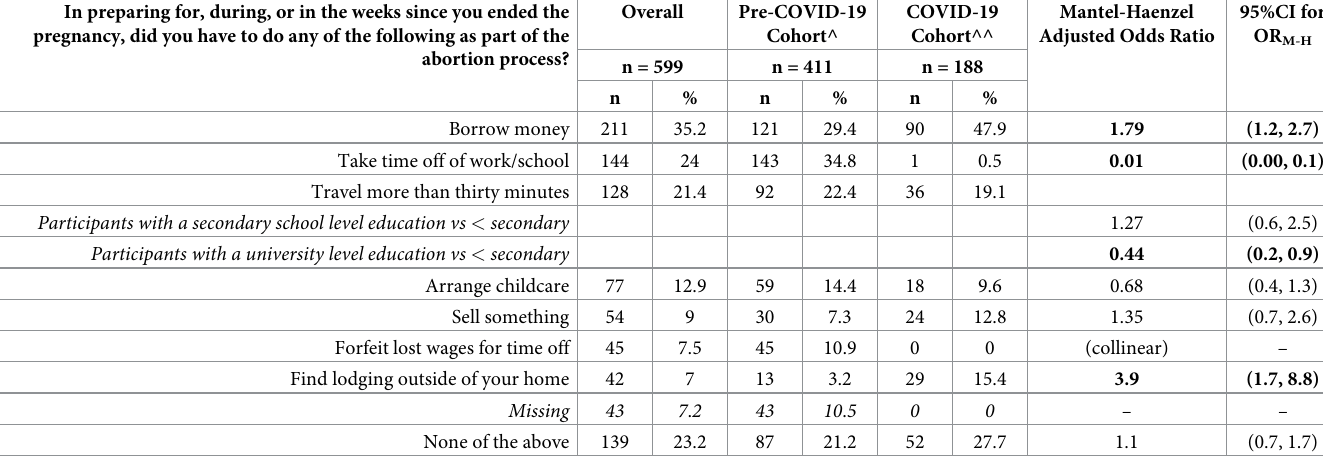
Table 2. Burdens experienced as part of a self-managed abortion process among 599 callers to a safe abortion hotline in Nigeria between October 2019 and June 2020. The first three columns present unadjusted proportions overall and by time period, and the two right-most columns display Mantel-Haenzel odds ratios (OR) for each burden adjusted for participant age and education at baseline, with corresponding 95% Confidence Intervals for the OR. Due to an interaction detected with educa- tion, the ORs for COVID-19 pandemic and having to travel more than 30 minutes are presented stratified by educational level. In preparing for, during, or in the weeks since you ended the pregnancy, did you have to do any of the following as part of